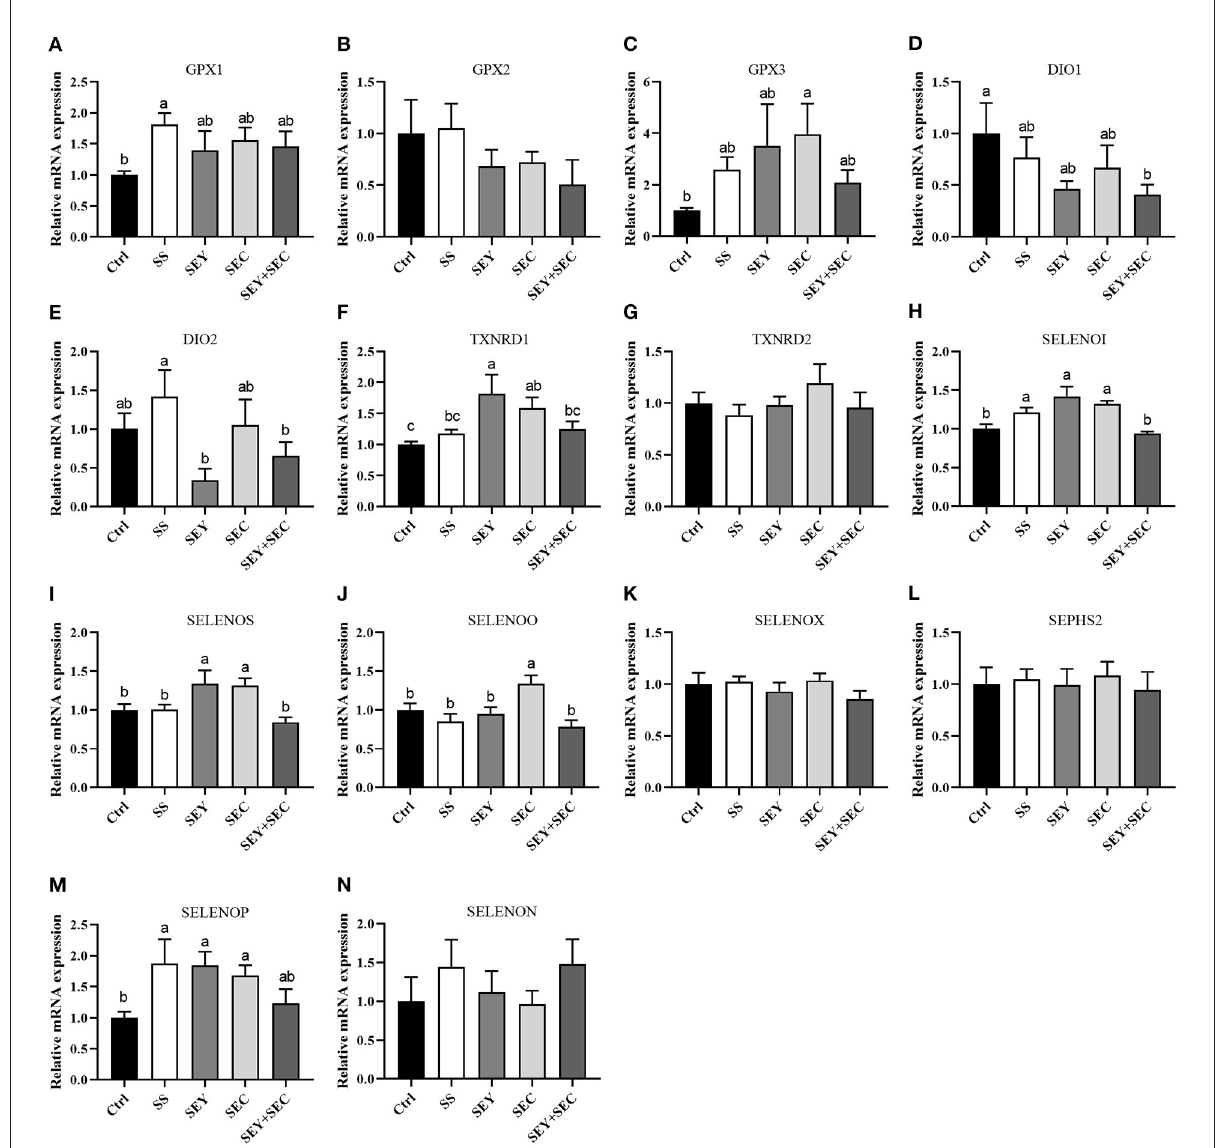
FIGURE5 Effects of different Se sources on the mRNA expression of selenoproteinss in the jejunum. (A–N) The mRNA expression of selenoproteins, including glutathione peroxidase 1 (GPX1), GPX2, GPX3, iodothyronine deiodinase 1 (DIO1), DIO2, thioredoxin reductase 1 (TXNRD1), TXNRD2, selenoprotein I (SELENOI), selenoprotein S (SELENOS), selenoprotein O (SELENOO), selenoprotein X (SELENOX), selenophosphate synthetase 2 (SEPHS2), selenoprotein P (SELENOP) and selenoprotein N (SELENON) in the jejunum. Values are means ± SEM, n = 6. a,b,c Means without a common letter differ, P < 0.05. Ctrl, control group; SS, sodium selenite; SEY, Se-enriched yeast, SEC, Se-enriched Cardamine violifolia ; SEY + SEC, Se-enriched yeast + Se-enriched Cardamine violifolia